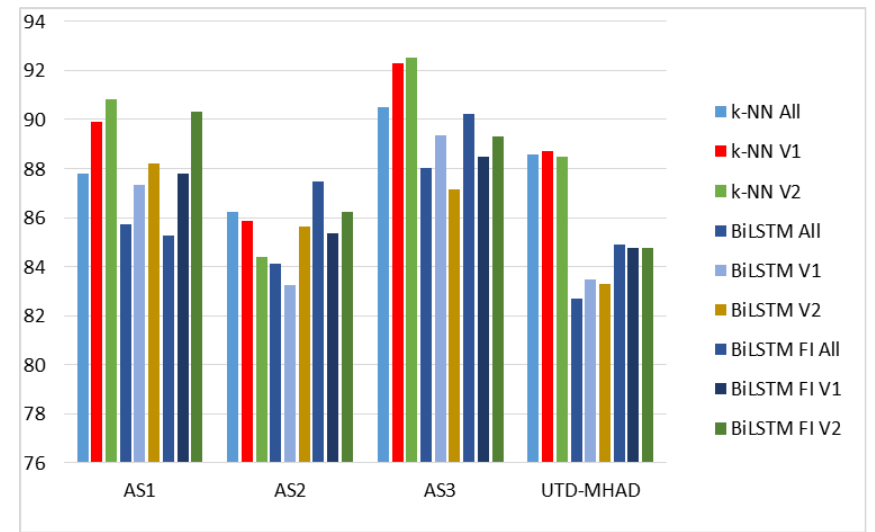
Figure 11. Comparison of the best recognition rates [%] obtained by various methods.